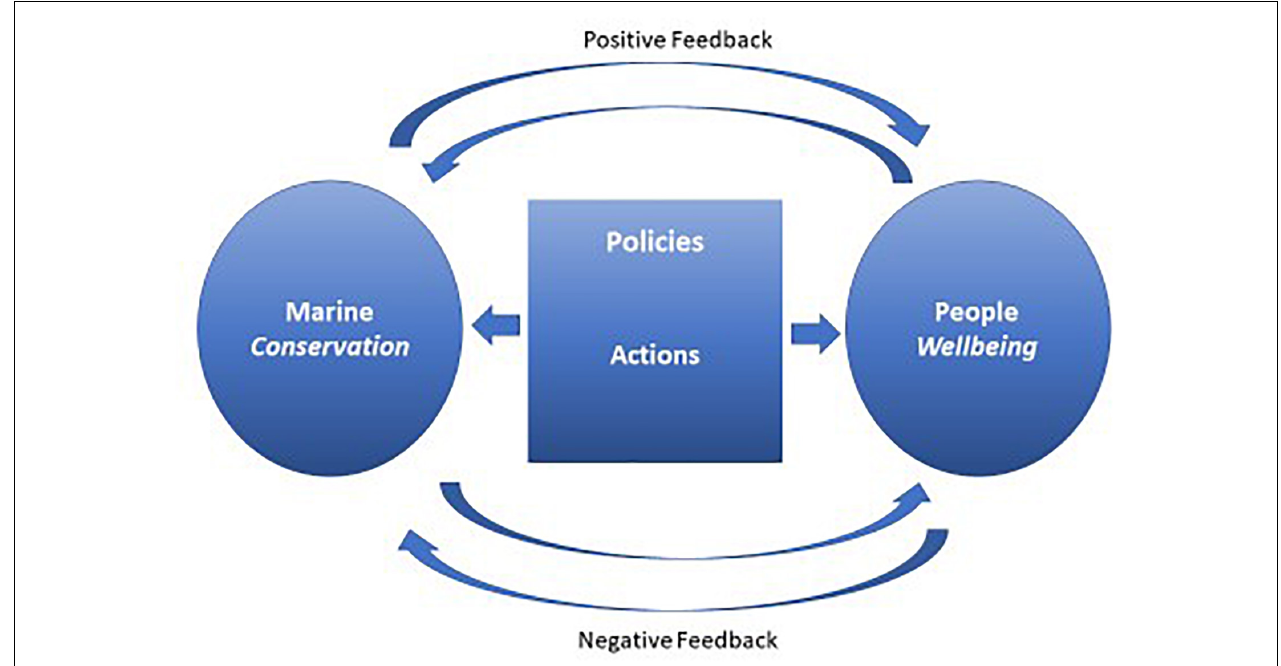
FIGURE 3 | Ending overfishing requires positive feedback between people and the